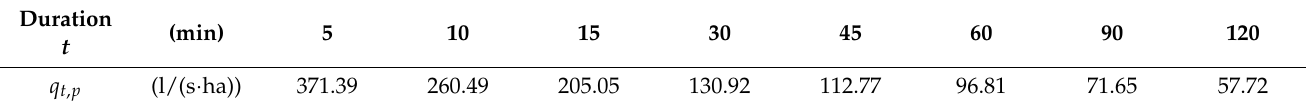
Table 8. Rainfall intensities q t , p of different event durations t for a 10-year event ( p =